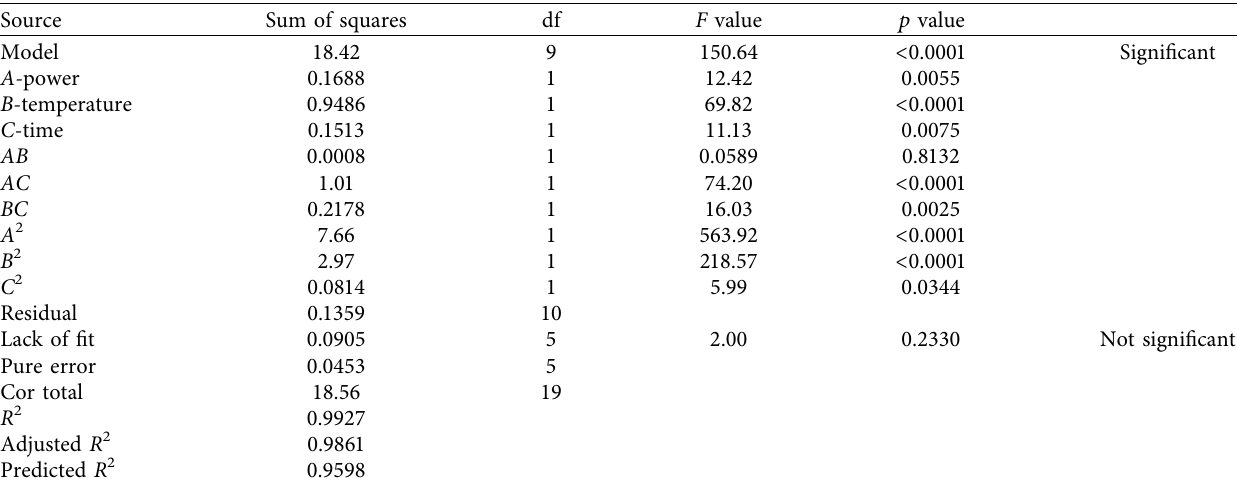
Table 3: Regression coefcients and ANOVA estimated for extraction yield of MAE moringa leaf extract.